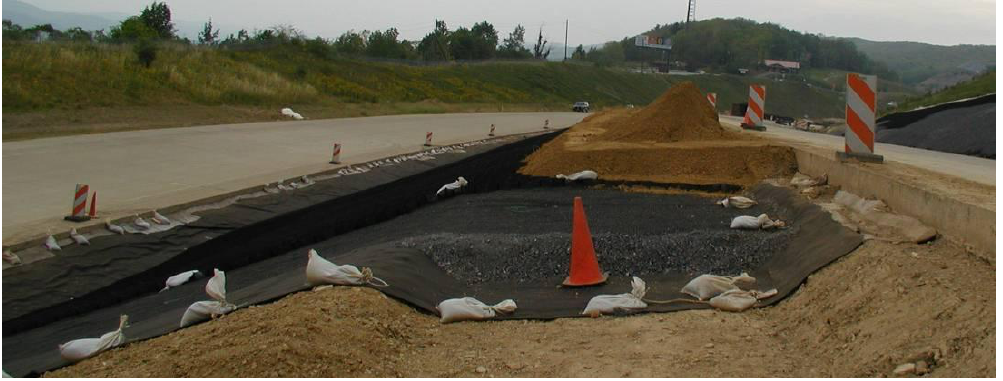
Figure 13. Photo showing cross section of geogrid anchor